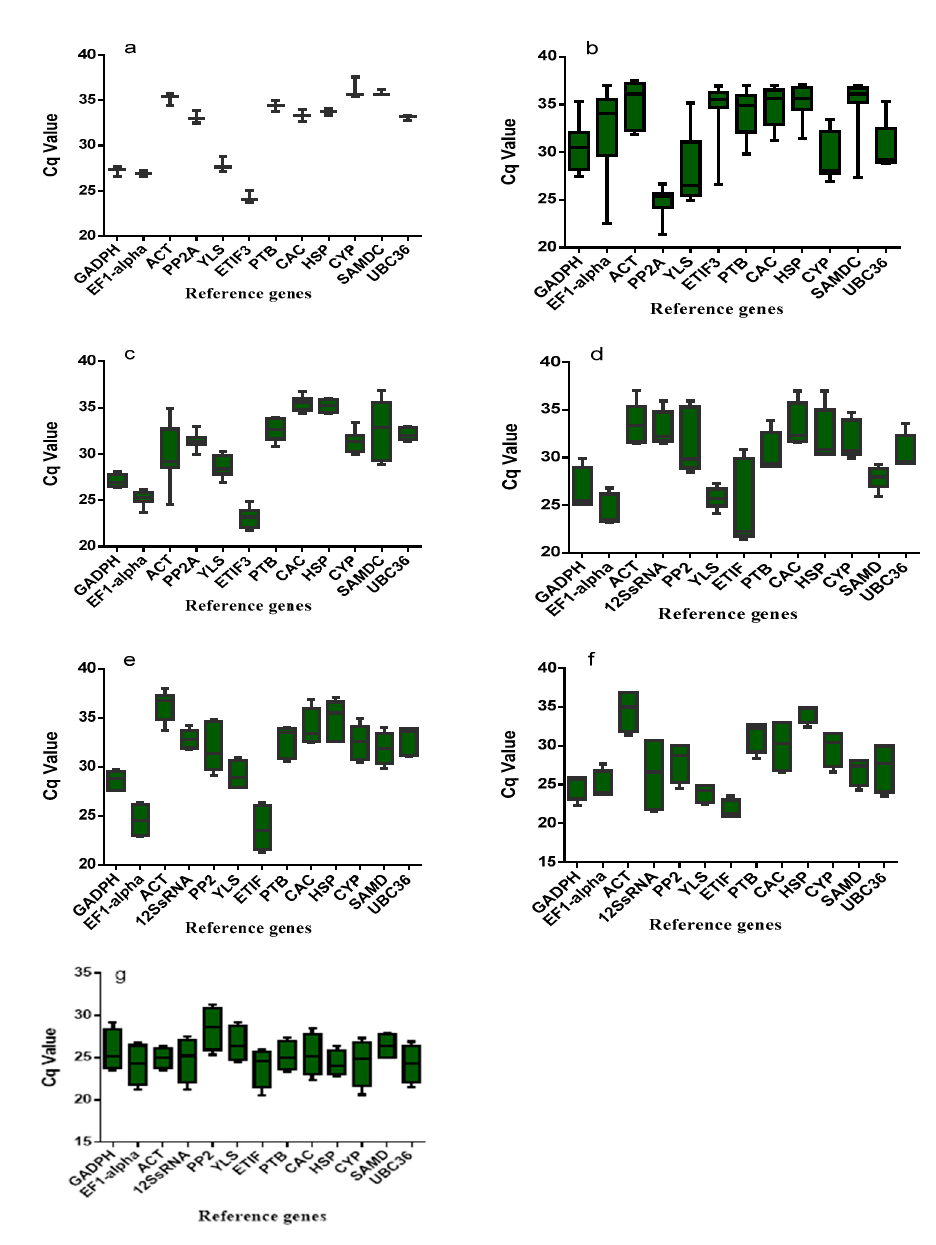
Figure 1. Expression profile of reference genes under control ( a ), salinity ( b ), drought ( c ), heat ( d ), cold ( e ), seedling ( f ), and development stage ( g ). Boxes indicate the 5th/95th percentiles, lines across the boxes depict the medians, squares. ACT = actin, GAPDH = glyceraldehyde-3-phosphate dehydrogenase, EF1-alpha = elongation factor 1 alpha, SAMDC = S-adenosylmethionine decarboxylase proenzyme, UBC36 = ubiquitin-conjugating enzyme E2 36-like, CYP = peptidyl-prolyl cis-trans isomerase CYP19-4-like, PTB = polypyrimidine tract-binding protein homolog 1-like, CAC = intracellular transport protein, PP2A = serine/threonine protein phosphatase 2A, ETIF3 = eukaryotic translation initiation factor3, HSP = protein microrchidia 2-like, YLS = thioredoxin-like protein.